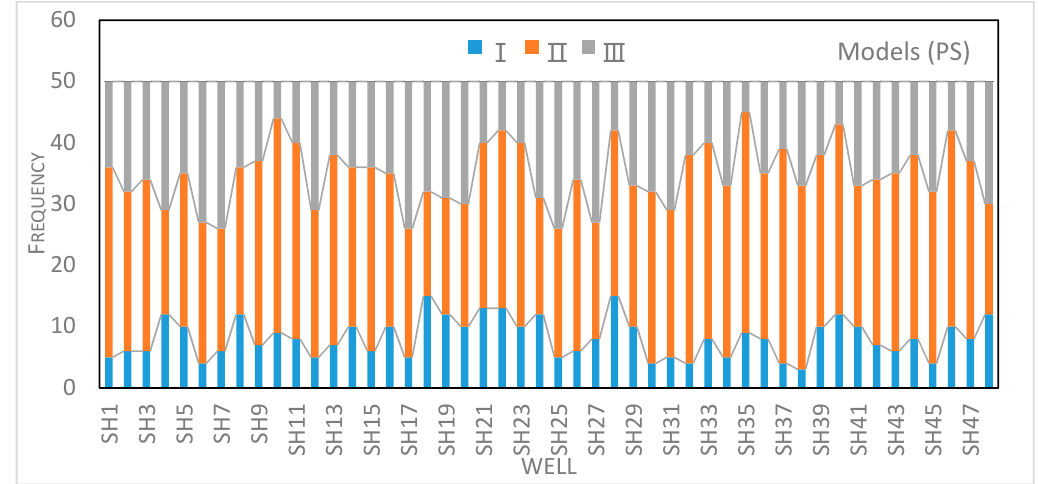
Figure 12. Statistics of comparison results of 48 horizontal wells in S6 area. These comparison results are based on the proposed method. As is shown in the Figure, type I and II are dominant.